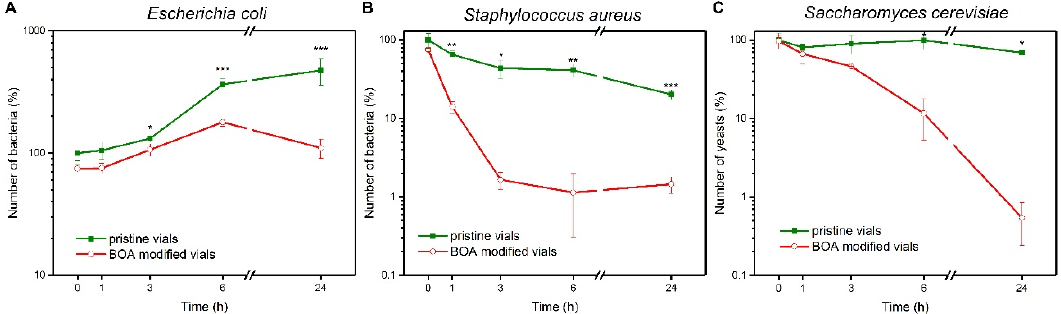
Figure 3. Comparison of growth-rate of ( A ) Escherichia coli BL21 (DE3) (initial concentration of 1.78 × 10 3 ± 2.38 × 10 2 CFU/mL), ( B ) Staphylococcus aureus WT (initial concentration of 1.53 × 10 4 ± 3.28 × 10 3 CFU/mL), and ( C ) Saccharomyces cerevisiae WT (initial concentration of 8.25 × 10 4 ± 1.84 × 10 4 CFU/mL) in pristine vials and BOA-modified vials. In all cases, BOA caused a decrease in the number of viable cells compared to pristine vials (* p < 0.05; ** p < 0.01; *** p < 0.001).